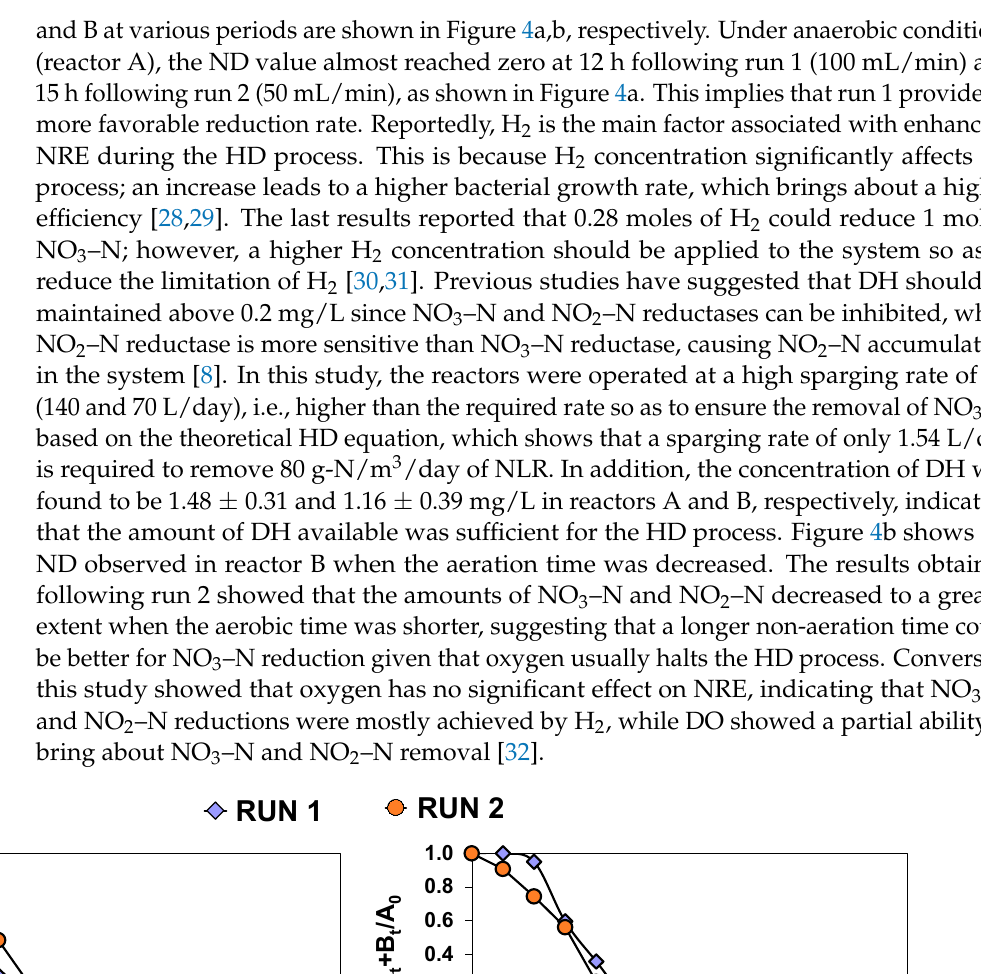
Figure 3. Effluent NO 3 –N and NO 2 –N concentrations and nitrogen removal efficiency (NRE) in ( a ) reactor A and ( b ) reactor B.